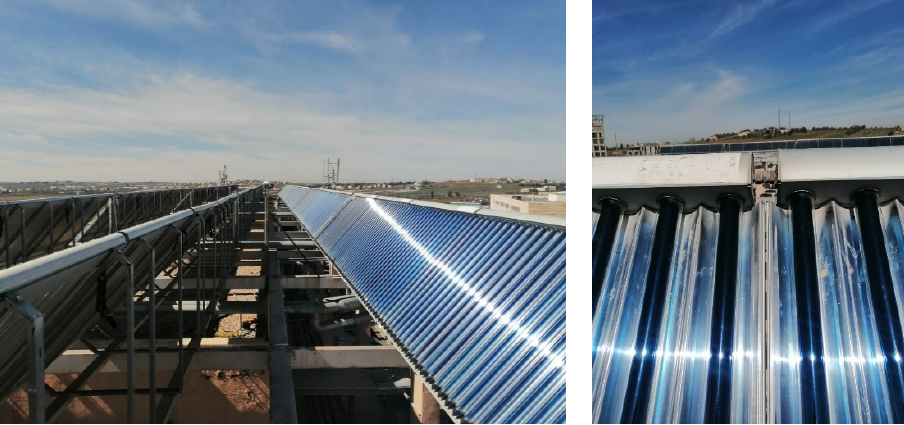
Figure 5. Solar collector field installed on the rooftop of Building C at GJU.